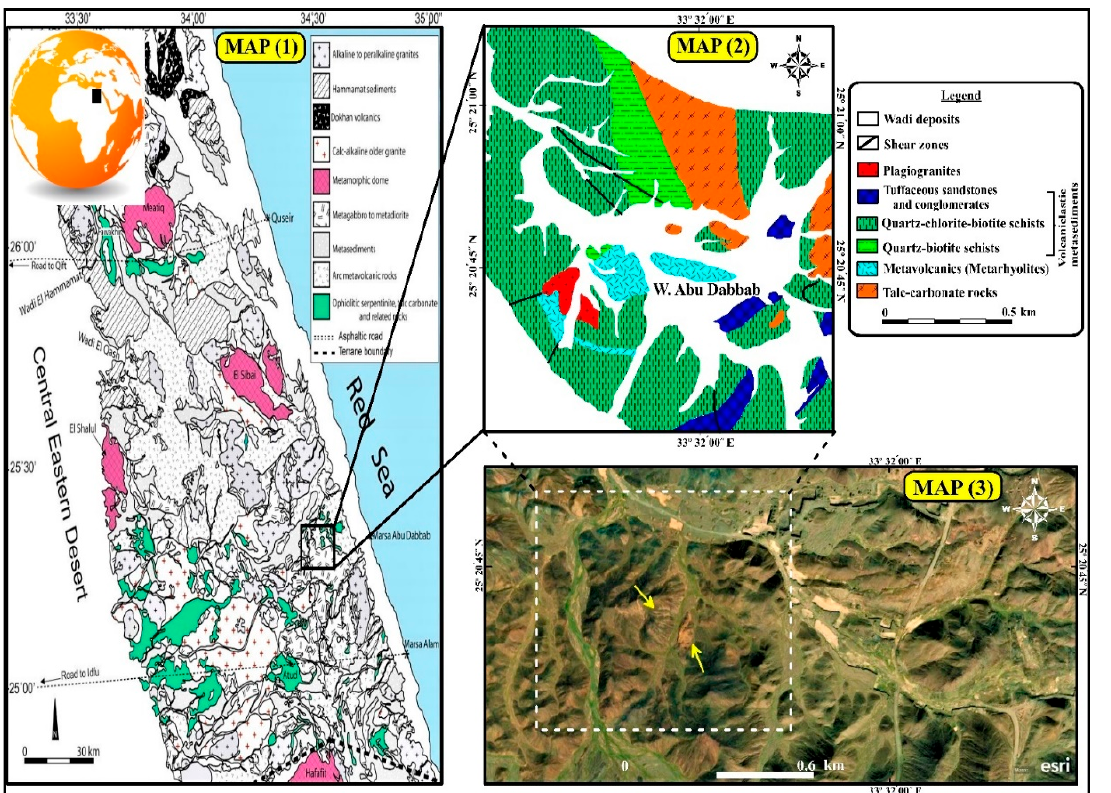
Figure 1. Map ( 1 ) Geological map for the Central Eastern Desert of Egypt, showing the Neoprotero- zoic basement rocks (modified from CONOCO map 1:500,000 and compiled from two quadrangle maps: Quseir quadrangle NG 36 NE and Gabal Hamata quadrangle NG 36 SE). Map ( 2 ) Detailed geologic map of the western part of Abu Dabbab area (modified after [31]). Map ( 3 ) The Google Earth imagery of Abu-Dabbab region; the yellow arrows are pointed to the plagio-granite location (central left).